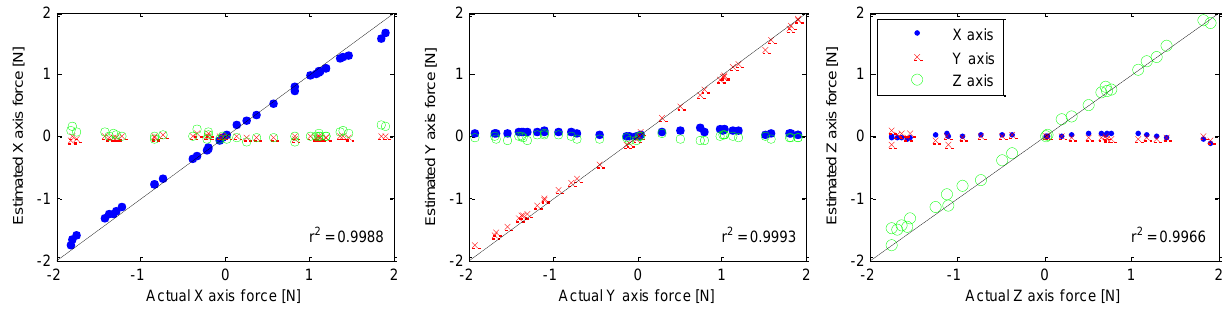
Figure 4. Sensor response to loads showing